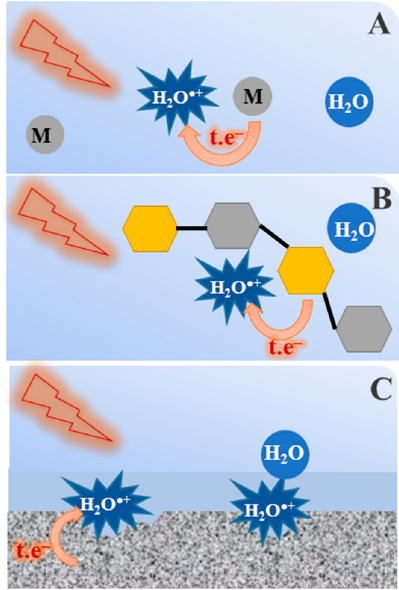
Figure 8. Under certain conditions, irradiated water can form a water radical cation that undergoes an electron transfer reaction in competition with the proton transfer reaction: ( A ) concentrated solutions in which the first solvation shell is occupied by solute molecules or ions; ( B ) water layers in contact with biomolecules; and ( C ) water/solid interface.